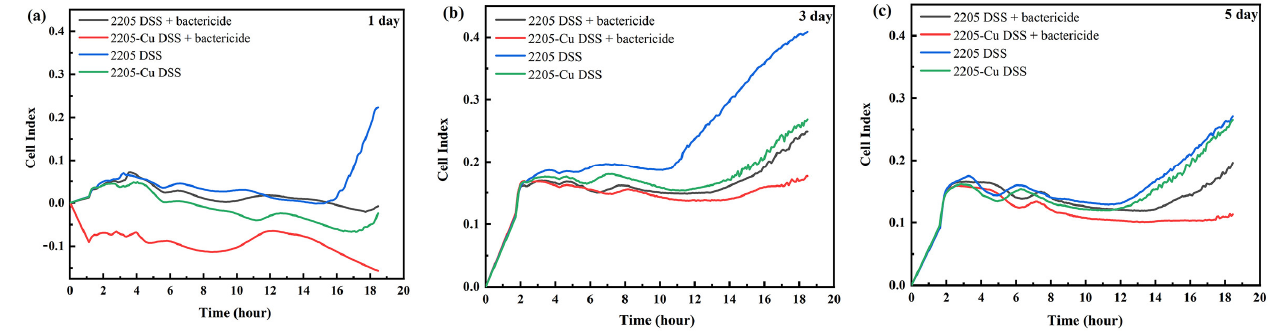
Figure 6. The cell growth curves established by cell impedance measurement under different groups cultured with P. aeruginosa cell concentration of 10 6 cells/mL for 1, 3, and 5 days.